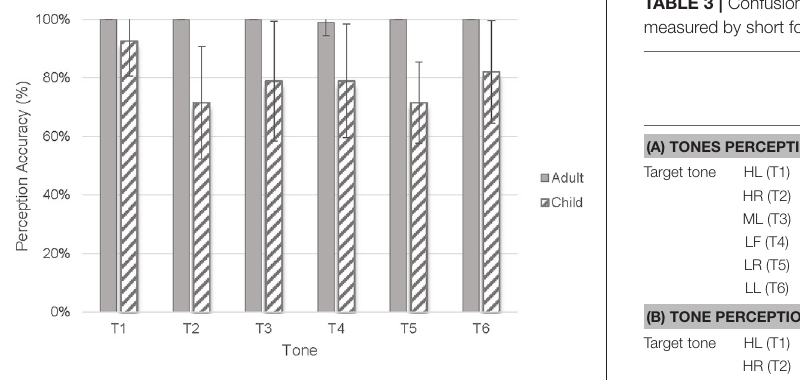
FIGURE 2 | Tone perception accuracy of children and adults.